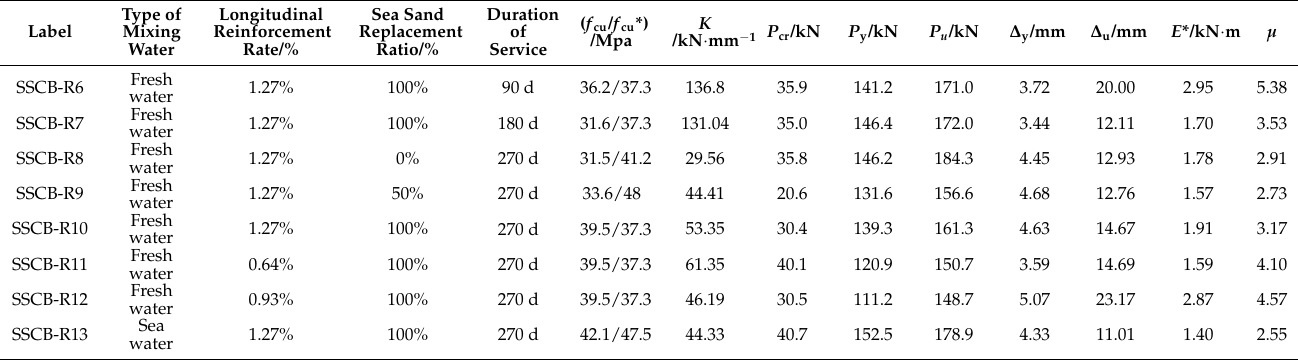
Figure 1. Schematic diagram of specimen and loading device. Table 1. Parameters of the specimen and test